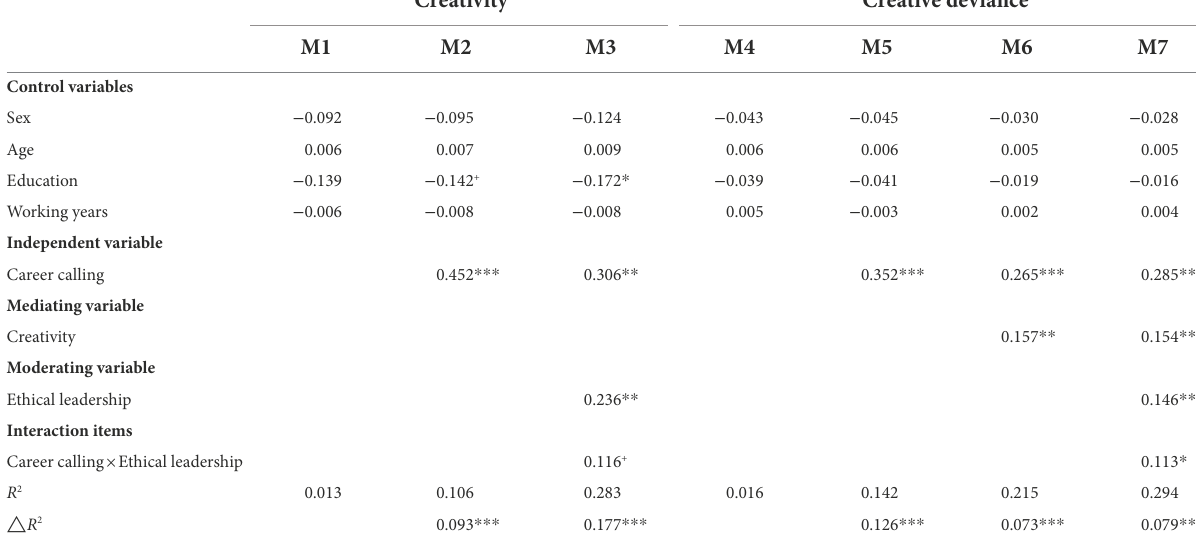
TABLE 3 Regression analysis